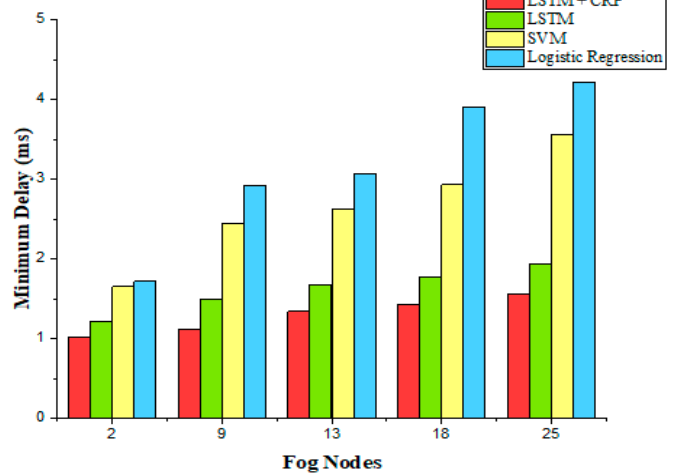
Figure 7. Prediction of minimum